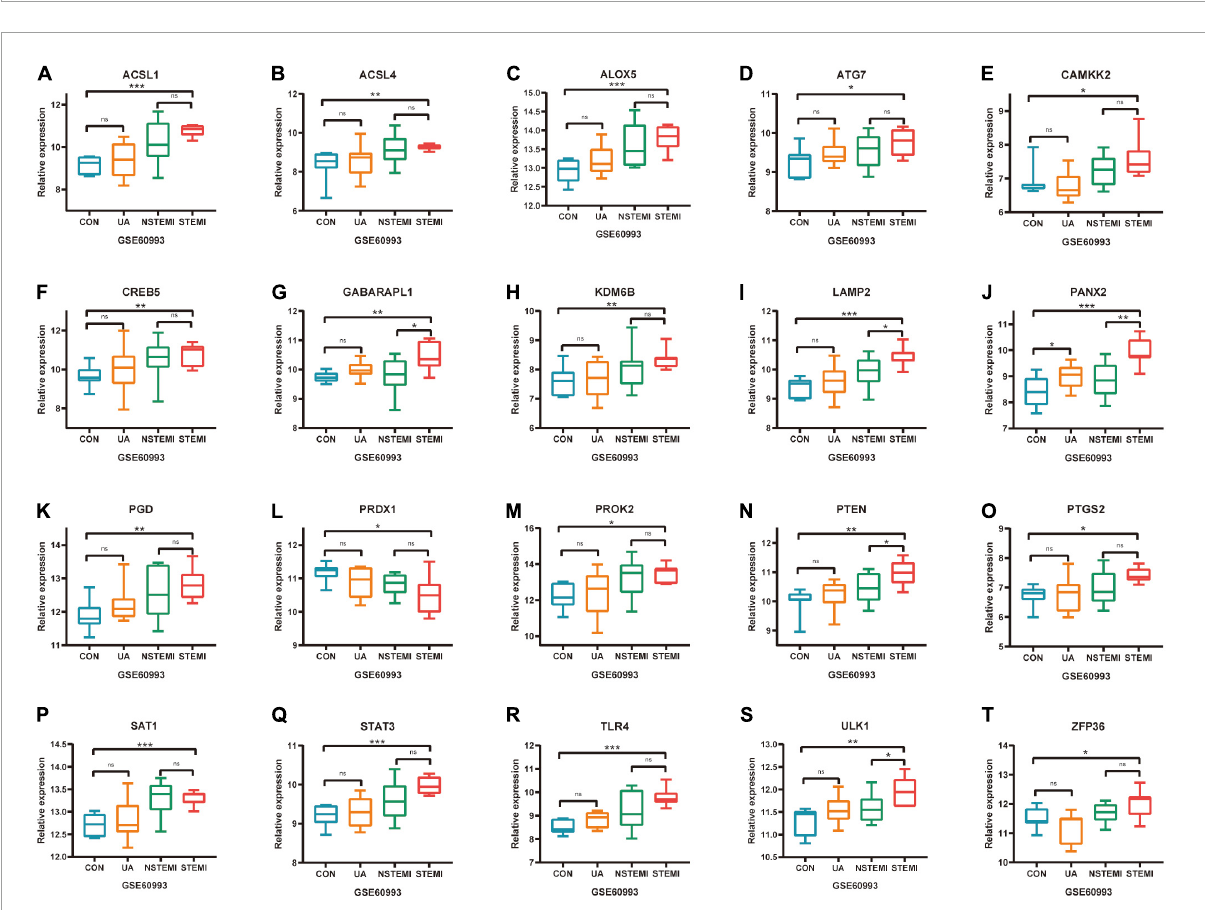
FIGURE6 Further validation of differentially expressed FRGs in external dataset GSE60993. (A–T) * P < 0.05; ** P < 0.01; *** P <